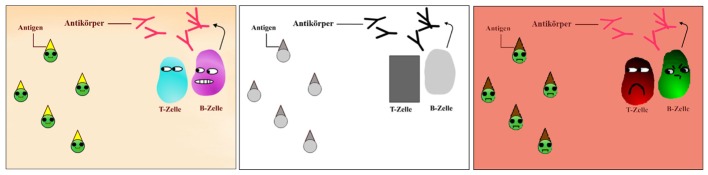
Pictures of emotional design variations of the multimedia learning environment: Intended-positive emotional design (left), intended-neutral design (middle), intended-negative emotional design (right).